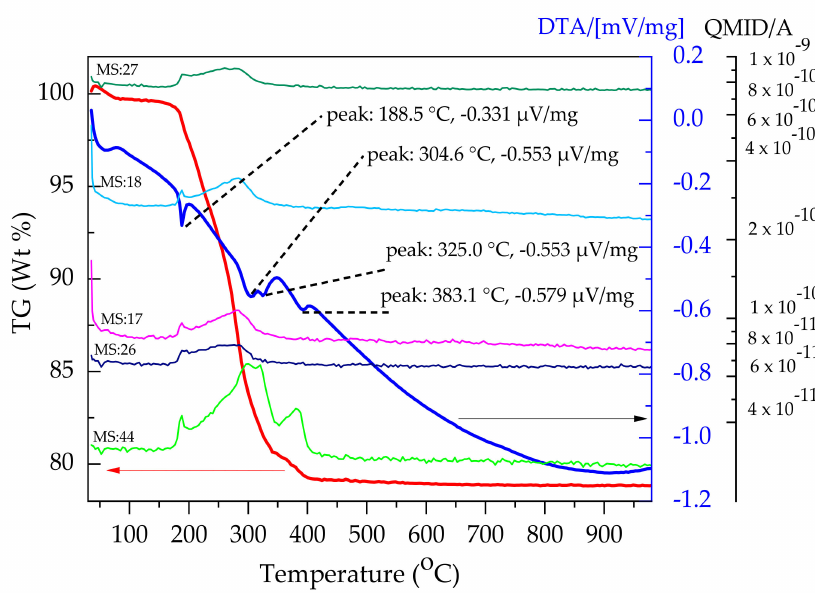
Figure 4. Thermogravimetric mass spectrometric coupled analyses of NiO-BZCY(54) 8 / 9 2 layer TG, DTA curves with the total ion current plot of the evolved